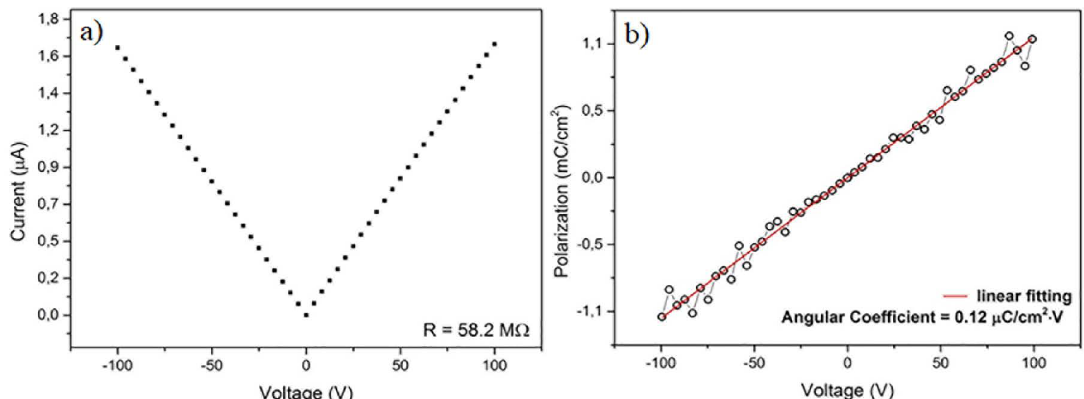
WO obtained by DC bias measurements. 2 4